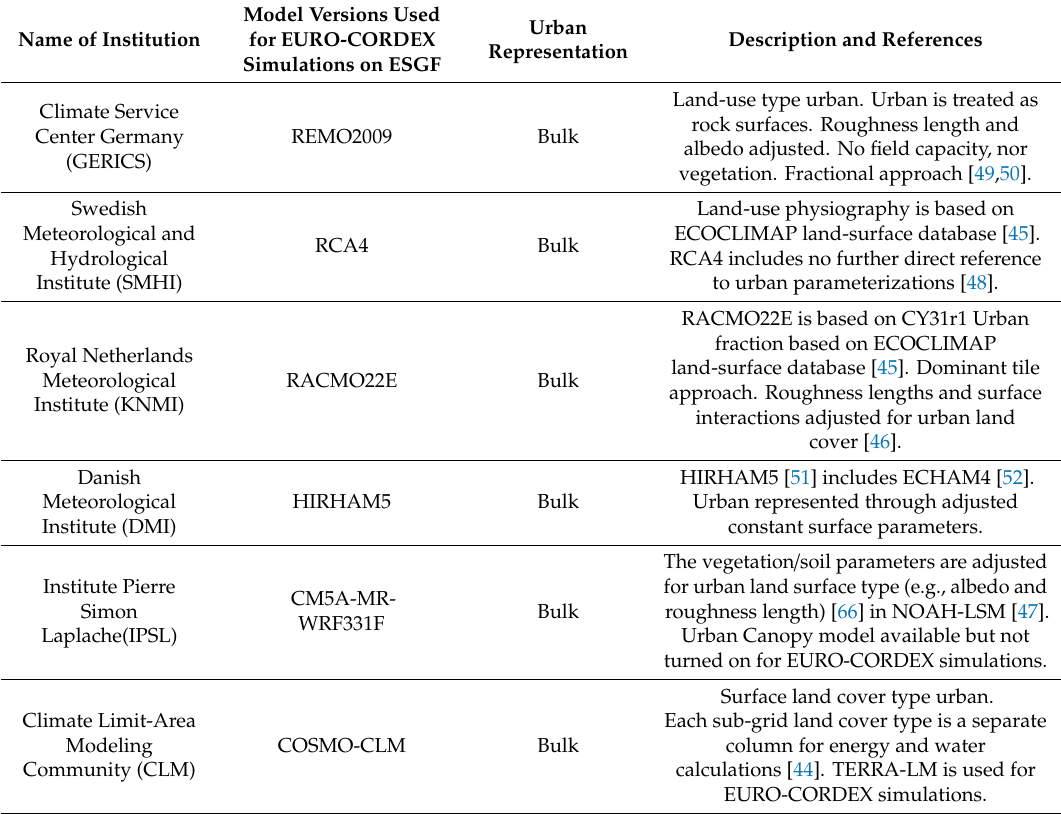
Table A1. EURO-CORDEX community survey outcomes on urban representation in RCMs used for EURO-CORDEX 0.11 ◦ simulations.